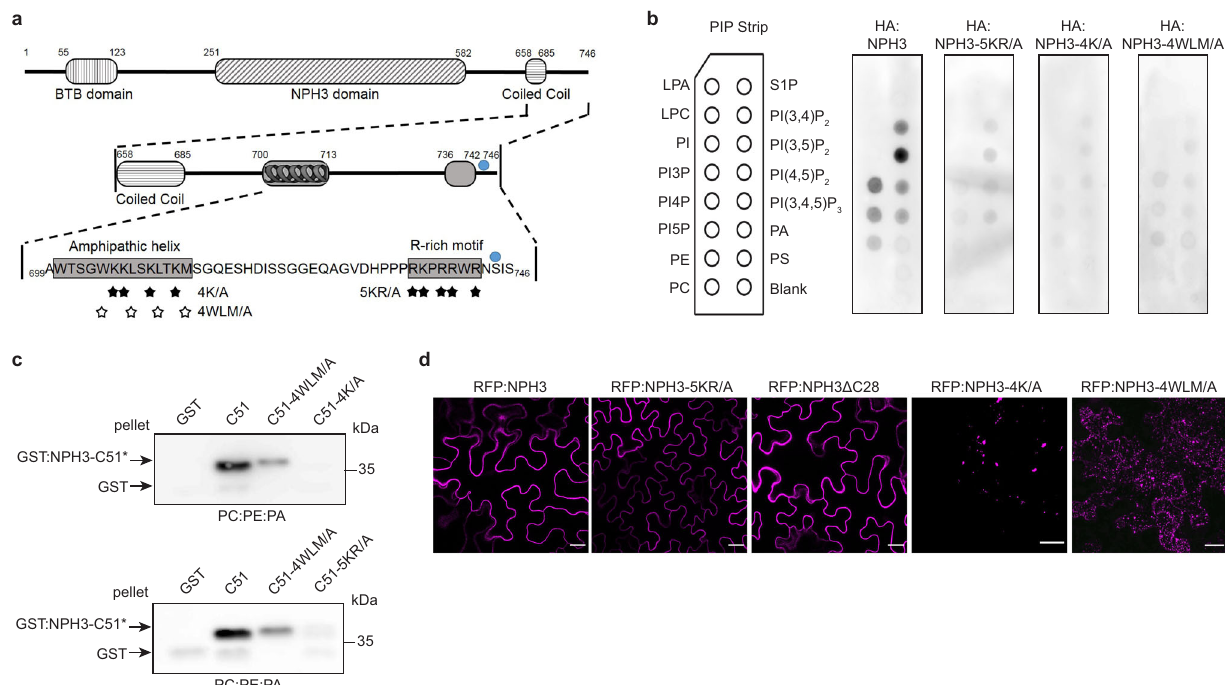
Fig. 2 An amphipathic helix within the C-terminal domain is required for NPH3 phospholipid binding, membrane association, and plasma membrane localization. a Domain structure and primary sequence of NPH3 showing the two putative BH domains (amphipathic helix and R-rich motif) within the C-terminal region. Stars depict residues substituted by alanine (A) in the NPH3 variants, blue circle depicts the 14-3-3-binding site (see Fig. 3). b Lipid overlay assay performed with in vitro-transcribed and -translated HA:NPH3 and HA:NPH3 variants characterized by the substitutions depicted in a . Immunodetection was conducted by using the anti-HA antibody. c Liposome-binding assay performed with puri fi ed GST and GST:NPH3-C51 variants (referred to as C51) characterized by the substitutions depicted in a . Large unilamellar liposomes containing the neutral phospholipids PE and PC mixed with the polyacidic PA were used. Anti-GST immunoblot of the pellet (see Fig. 1c) is shown. d Representative confocal microscopy images of leaf epidermal cells from dark-adapted N. benthamiana transiently expressing RFP:NPH3 variants characterized by the substitutions depicted in a as well as RFP:NPH3 Δ C28. Expression was driven by the 35S promoter. Z-stack projections of RFP:NPH3-4K/A and RFP:NPH3-4WLM/A are shown. RFP:NPH3 is shown as control. Scale bars, 25 μ m. Experiments b – d were performed at least three times with similar